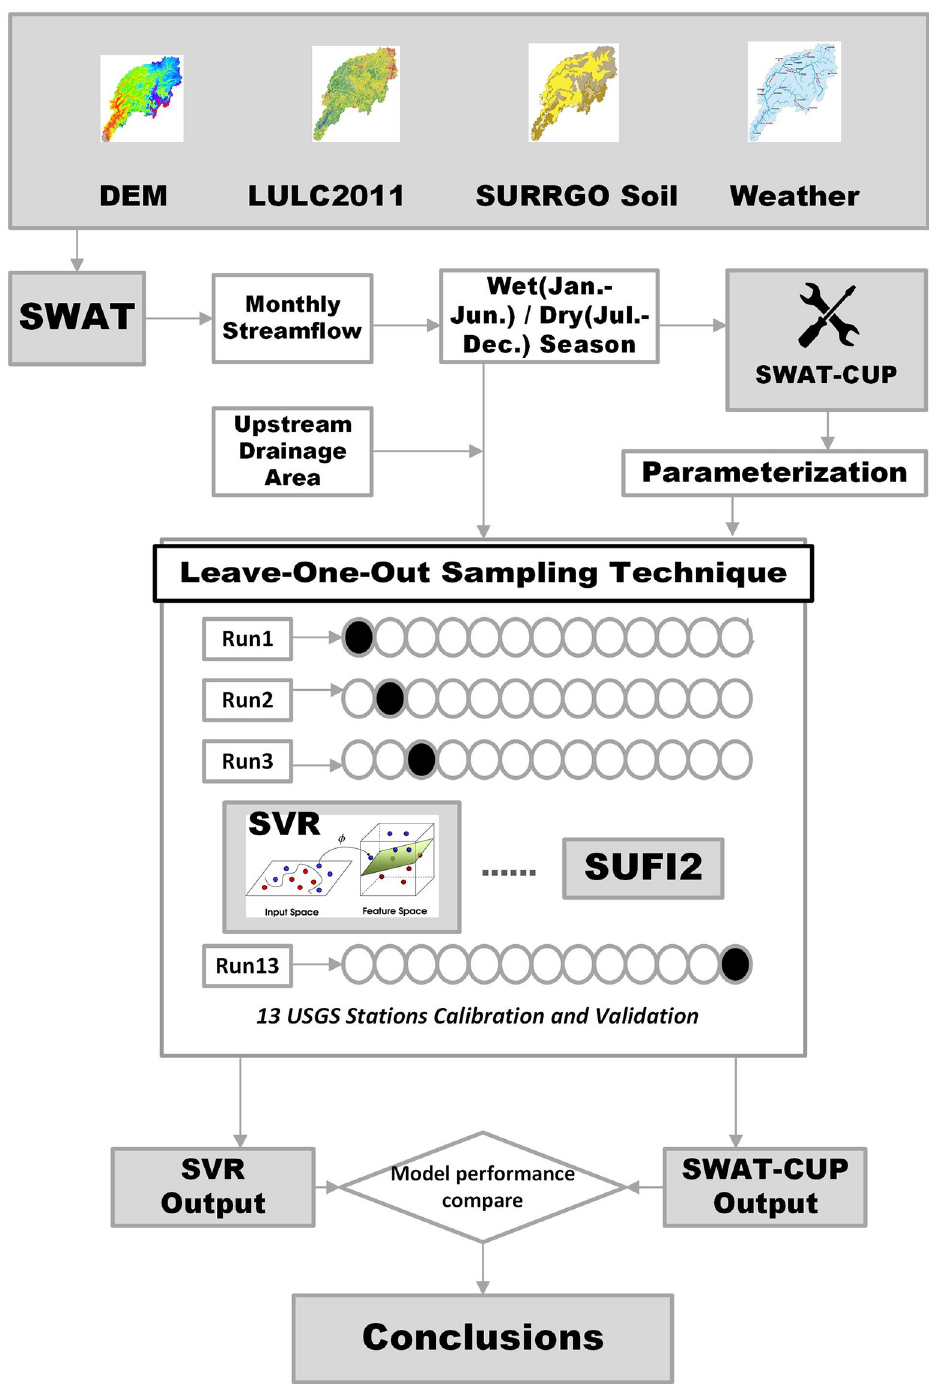
Fig 5. Research flowchart of streamflow prediction by SWAT-SVR and SWAT-CUP.